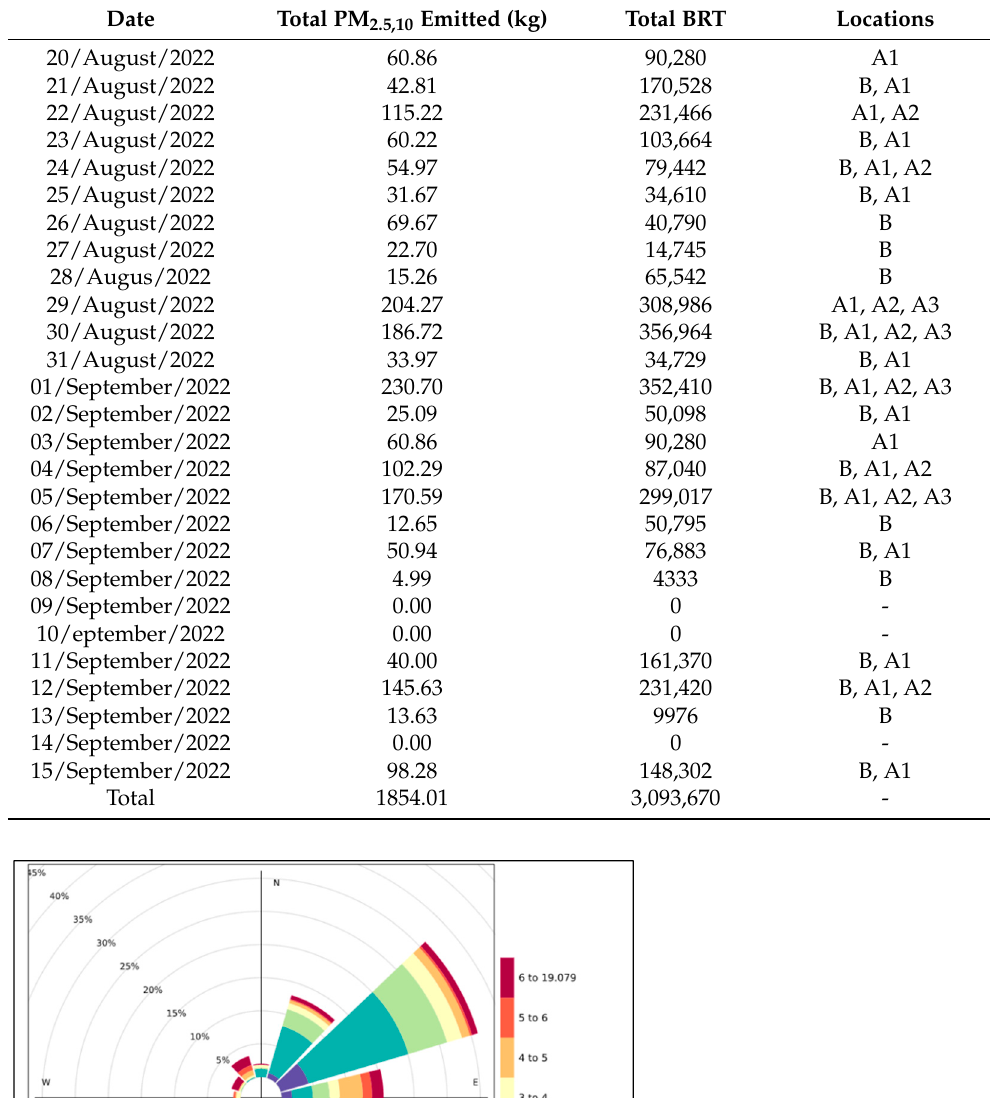
Table 2. Total estimated amounts of PM 2.5,10 emitted from cruise ships during the experimental period including specific technical characteristics and operational conditions [22,25].